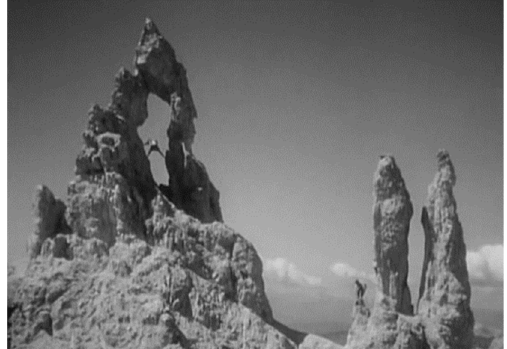
Figure 3. Gita climbing the “Window Towers” in Der große Sprung.